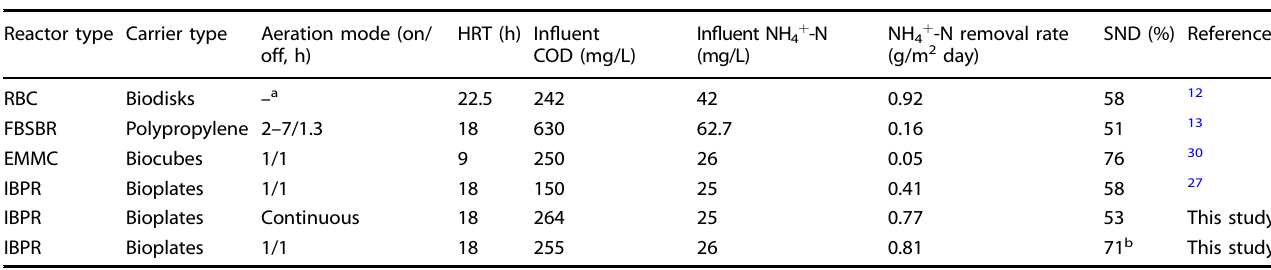
Fig. 3 Performance comparison of the IBPR between CA and IA modes. a COD and NH 4 + -N removal and b SND ef fi ciencies in continuous aeration (CA) and intermittent aeration (IA) modes. The concentration pro fi les of c NH 4 + -N, d NO 3 − -N, and e COD along the IBPR. Error bars represent standard deviations (SD) derived from the corresponding data collected from different compartments of the reactor during the periods of CA and IA operation. Statistically signi fi cant difference between the data of two aeration modes: # p < 0.05 (paired sample t test). n: sample size, d.f.: degree of freedom, t: t -value, p: p -value. Table 1. Comparison of SND performance by different